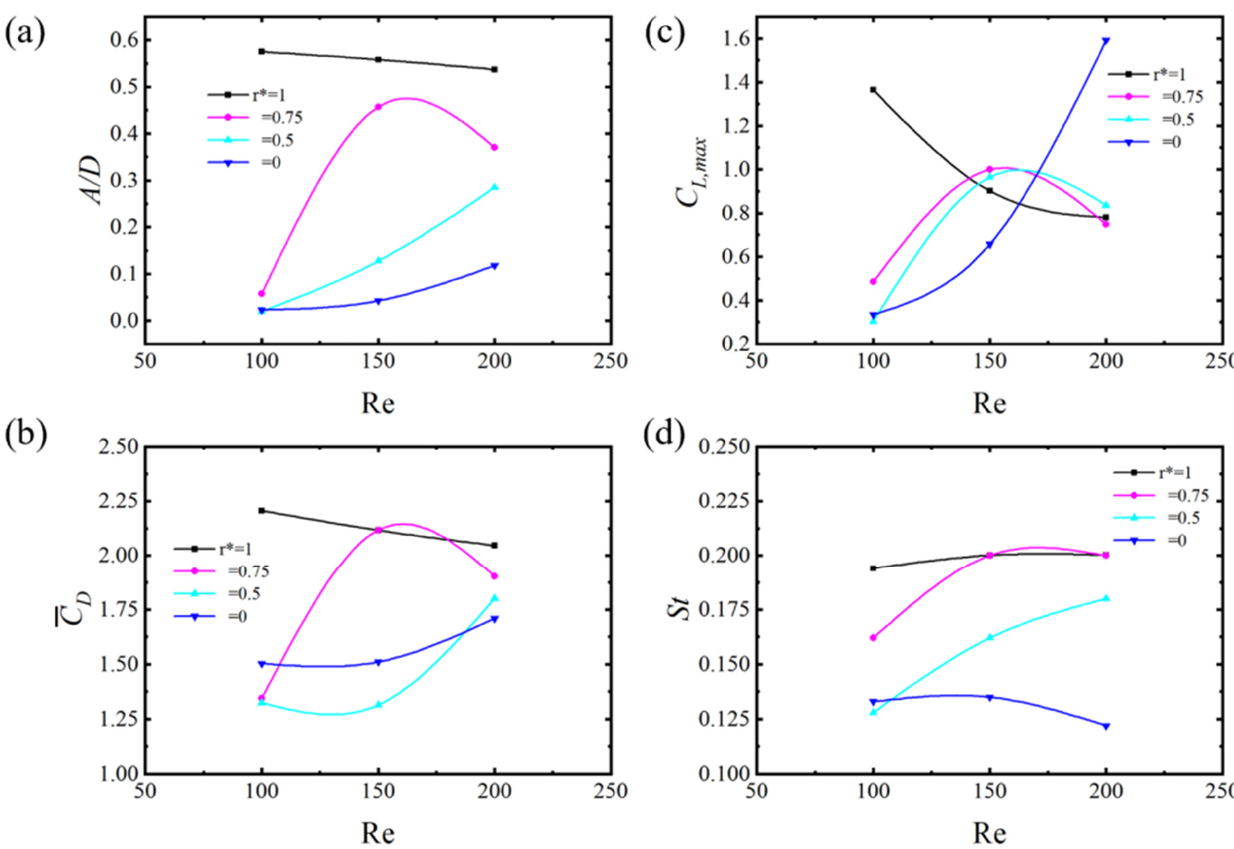
(cid:3002) vs. Re, ( b ) C D vs. Re, ( c ) C L vs. Re, ( b ) 𝐶 (cid:3005) vs. Re, ( c ) 𝐶 (cid:3013) D (cid:3005)